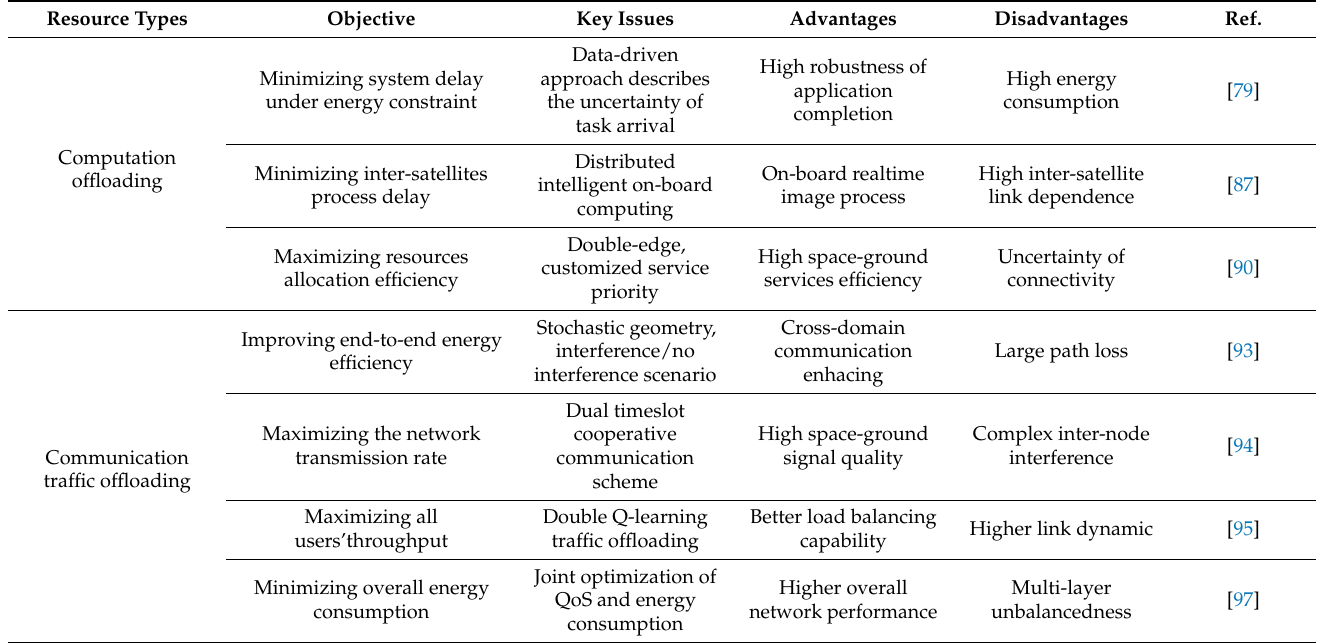
Table 2. Summary of related works on network resources